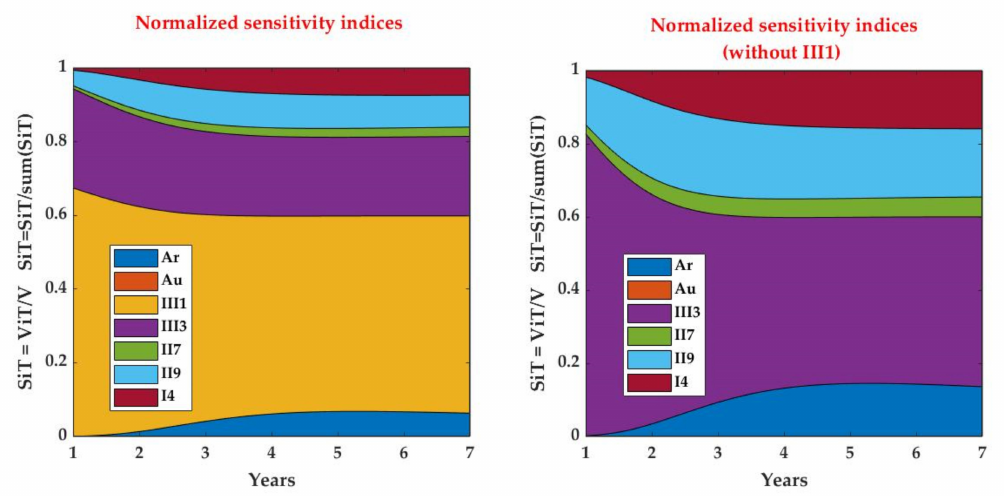
Figure 7. Normalized sensitivity indices during the period from 2019 to 2025 with the distribution of EV production (III1) and without